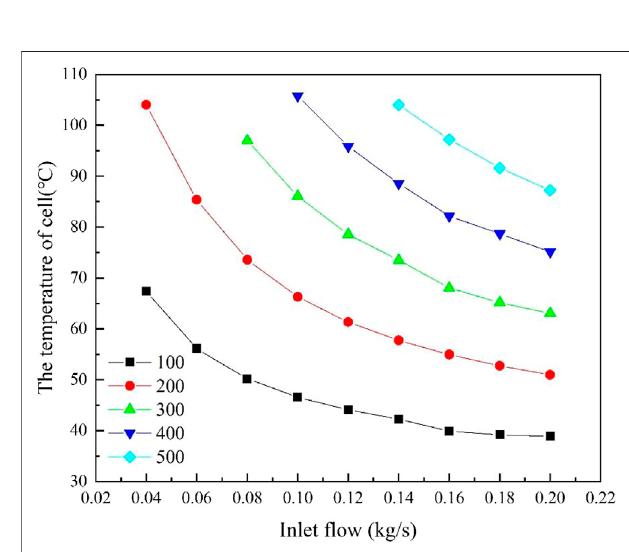
FIGURE6| In fl uenceofinlet fl owonthetemperatureofthecellunderthe single-jet nozzle.